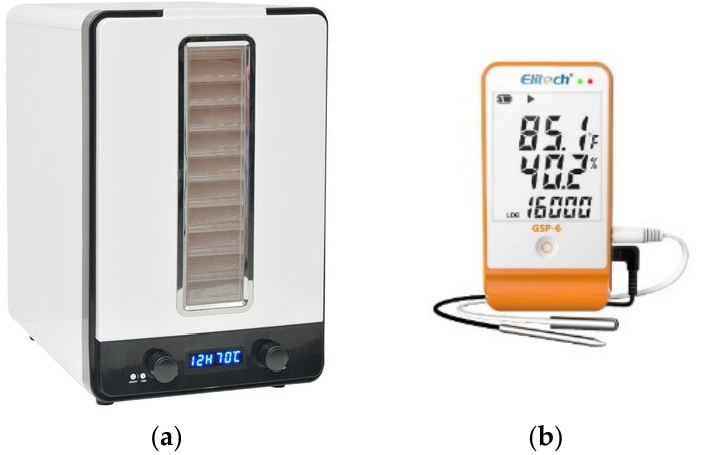
Figure 3. ( a ) Electric commercial dryer; ( b ) data loggers.